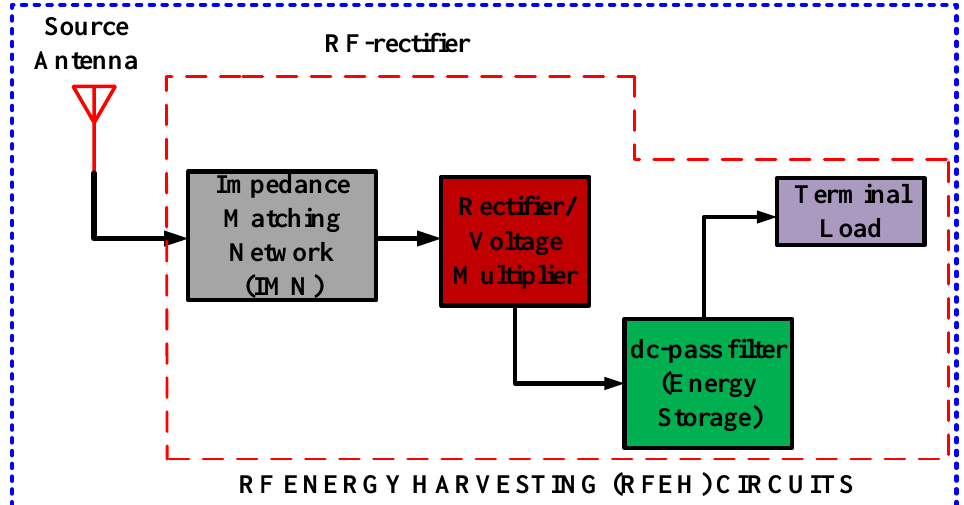
Figure 2. Block diagram of the basic RFEH system